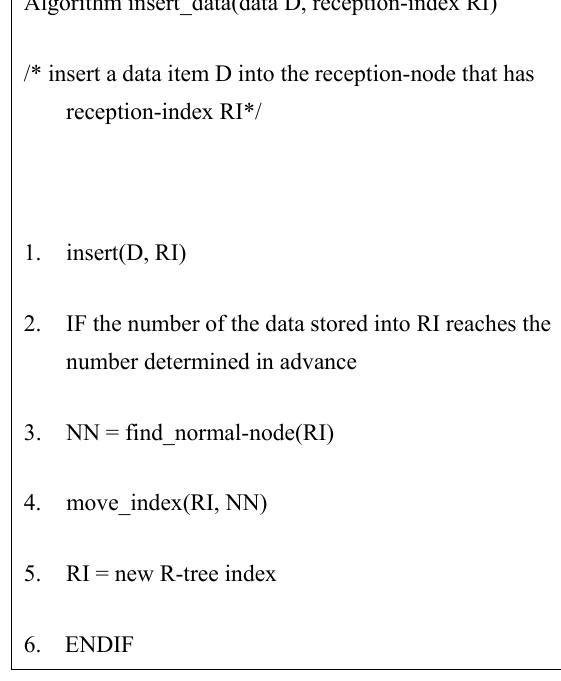
Fig. 3. The insertion algorithm at a